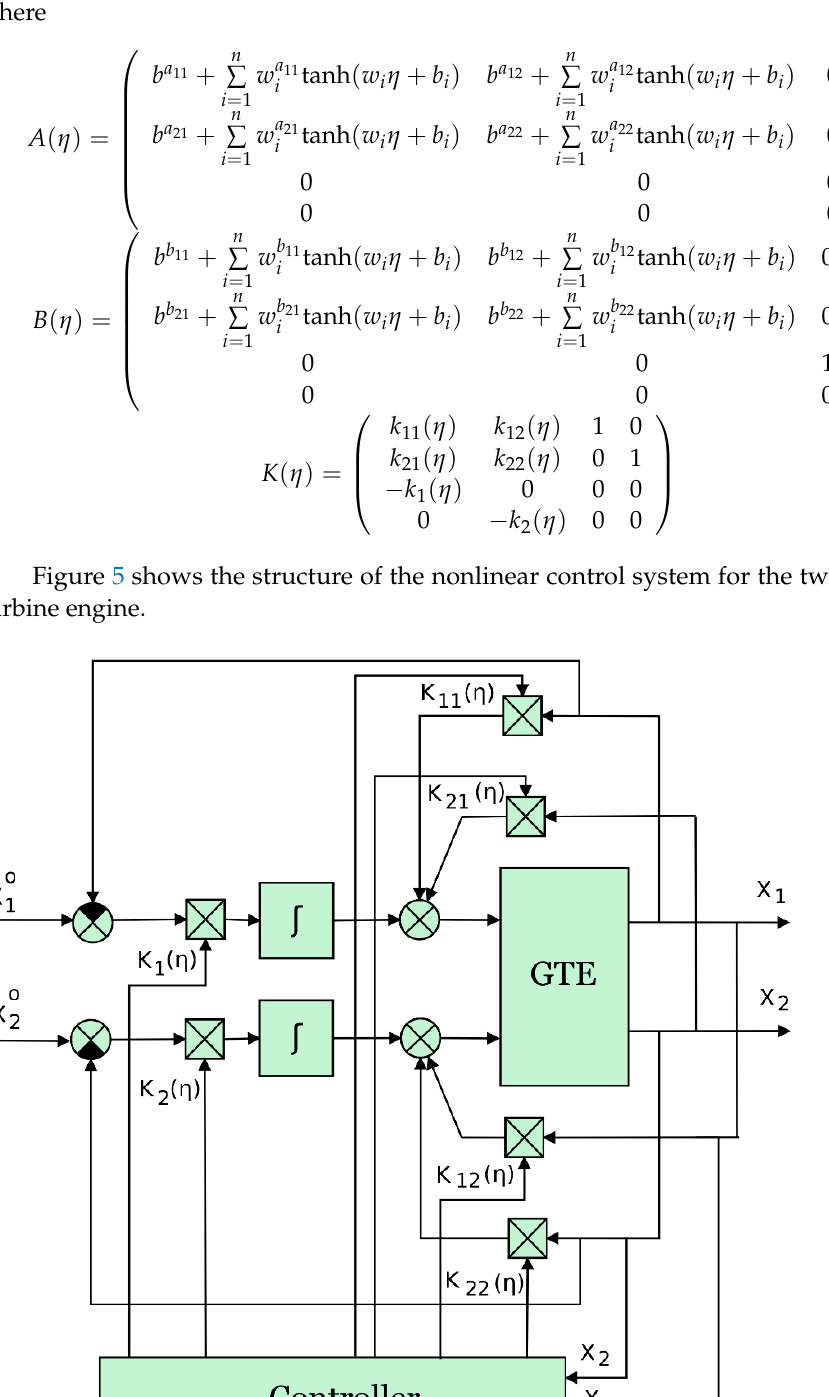
ues of the coefficients of the dynamic model of a gas turbine engine (20), where input “Mode” = (0.68, …, 0.95).